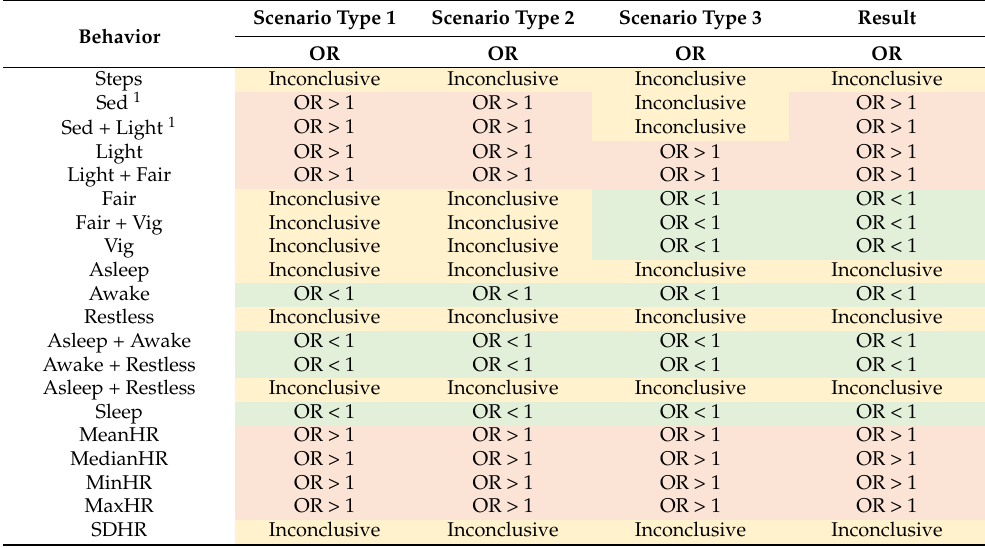
Table A12. Results across all conditional logistic regression models in all validation scenario